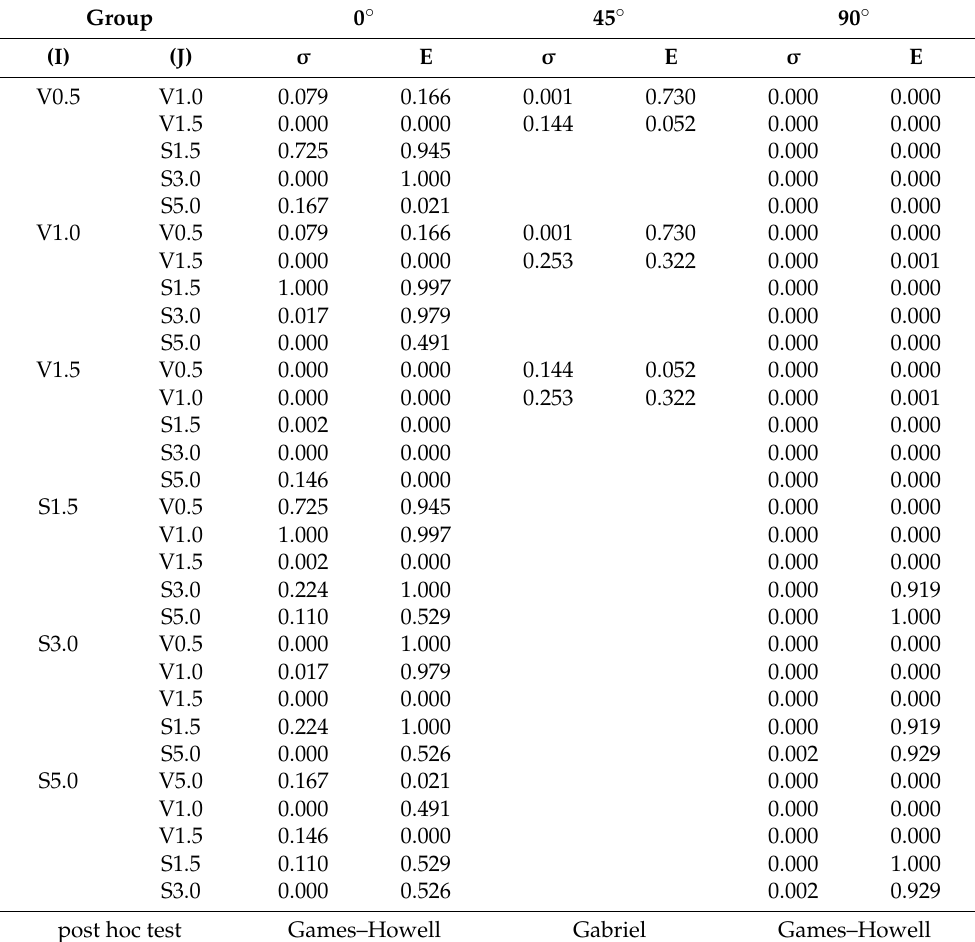
Table A1. p -values of the post hoc tests for the thicknesses as well as different load angles using strength and stiffness of the